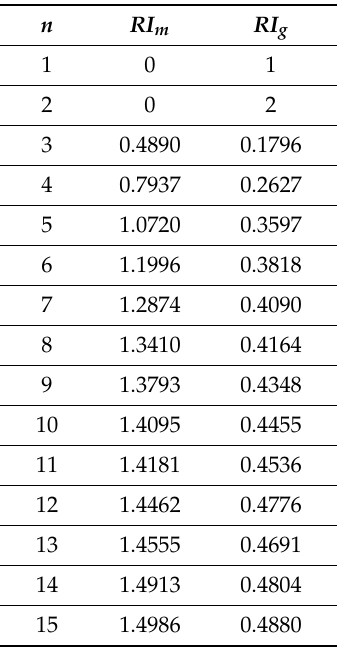
Table 4. Random consistency index (RI) scale.